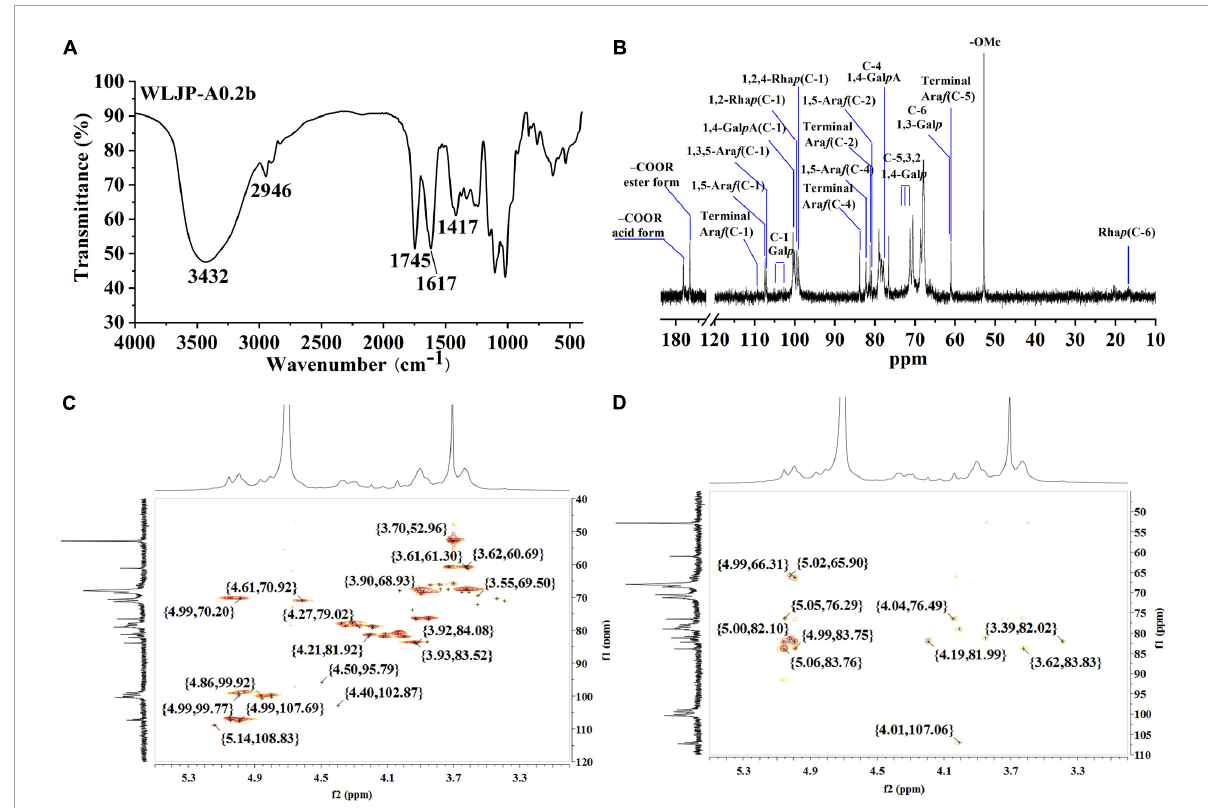
FIGURE2 Structural analysis of WLJP-A0.2b. (A) Fourier transform infrared (FT-IR) spectrum. (B) 13 C nuclear magnetic resonance (NMR) spectrum. (C) HSQC spectrum. (D) HMBC